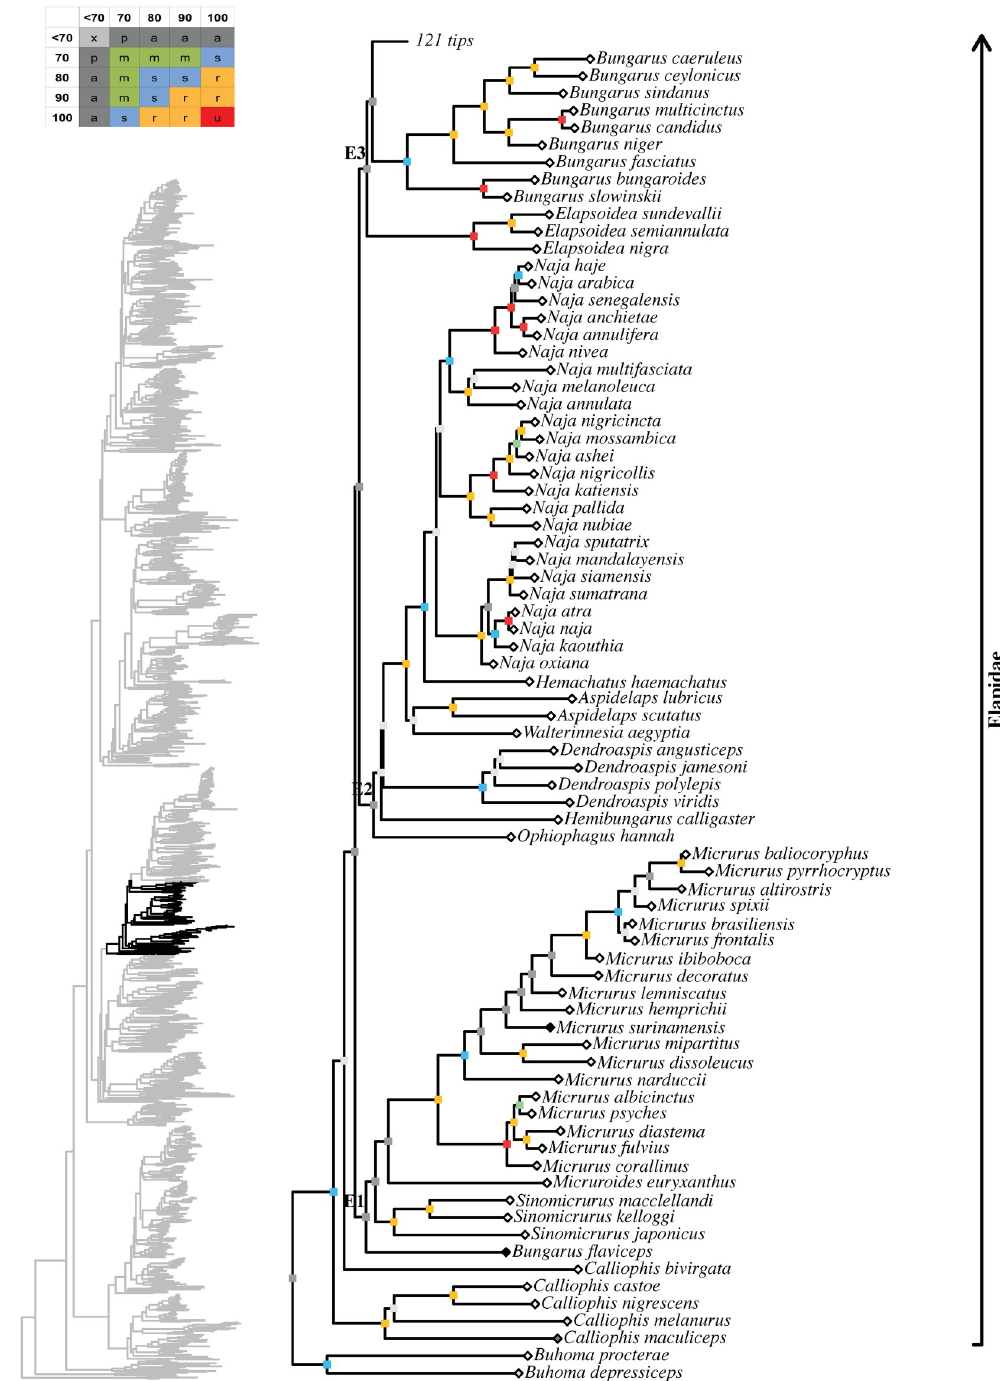
Fig 12. Maximum likelihood species-level phylogeny of Colubroides (continued). Family Elapidae.